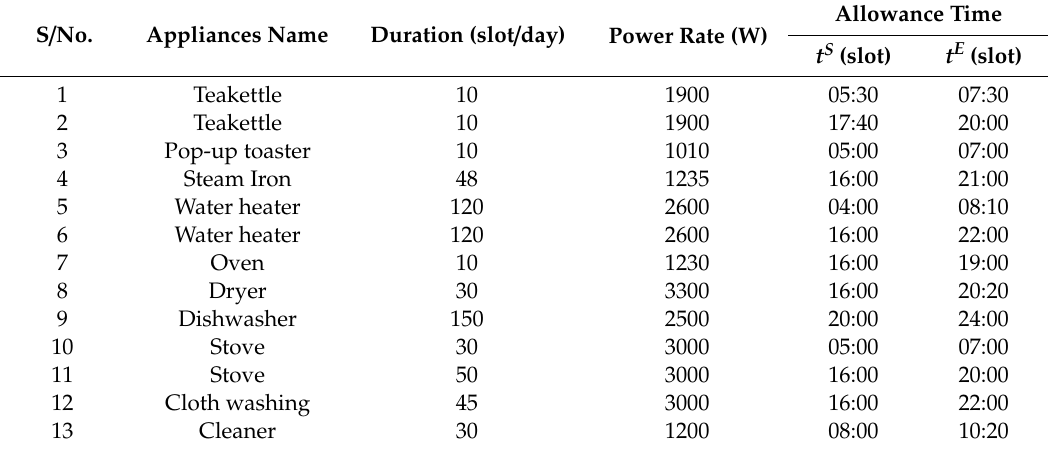
Table 5. The appliances data